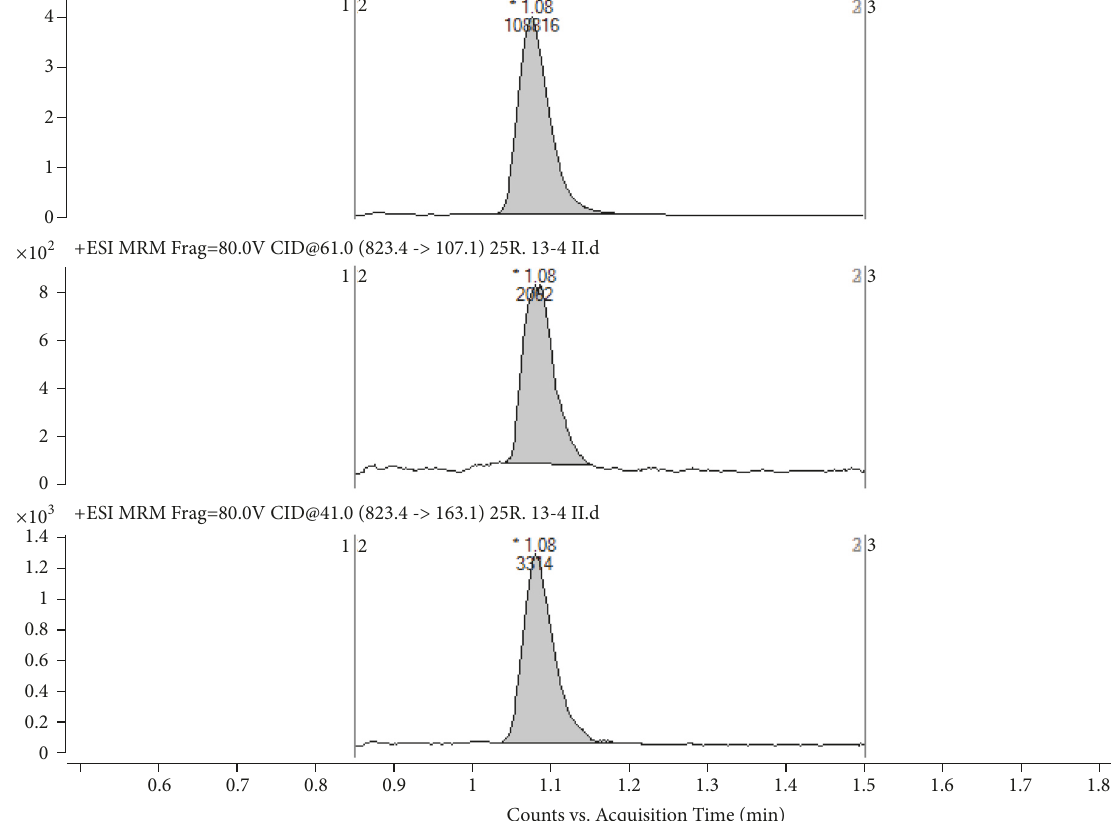
Figure 2: LC-MS/MS chromatogram of a real plasma sample from a patient, receiving 450 mg RIF every 12 hours. The determined RIF concentration is 28.3 𝜇 g/L. Top trace represents IS; middle trace represents RIF qualifier ion, and bottom trace represents RIF quantifier